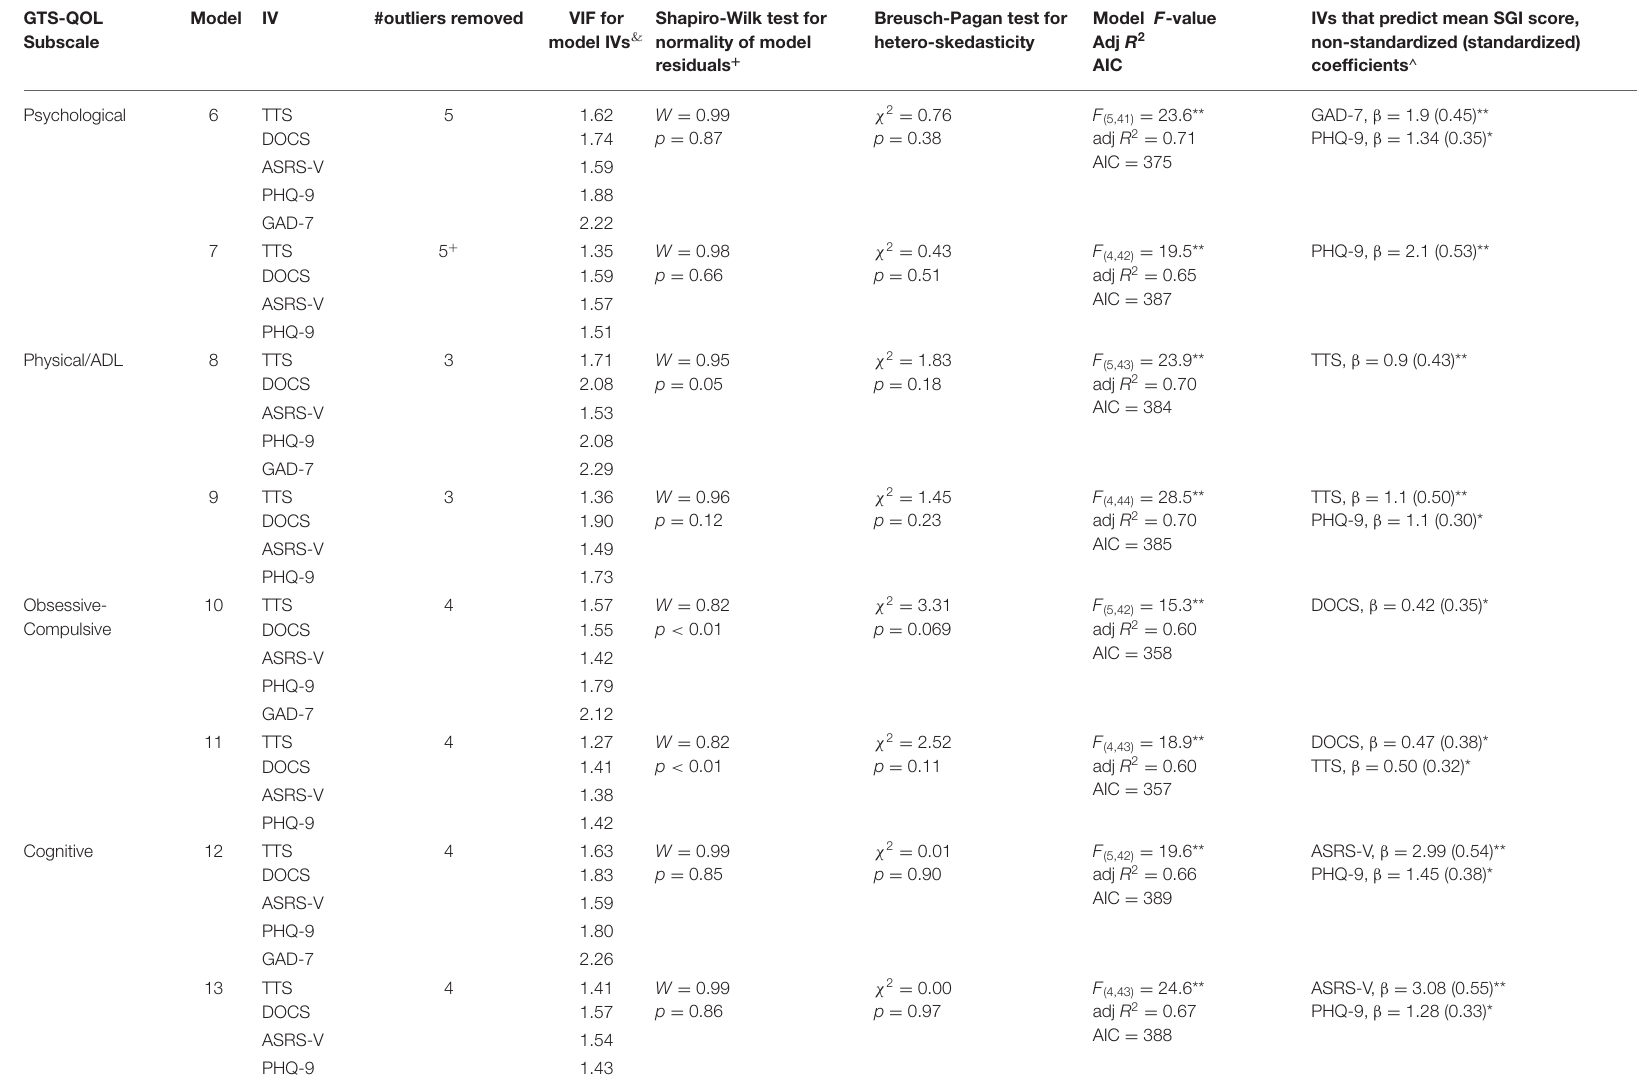
TABLE 6 | Regression analyses with respective GTS-QOL subscales as dependent variable. GTS-QOL Model IV #outliers removed VIF for Subscale